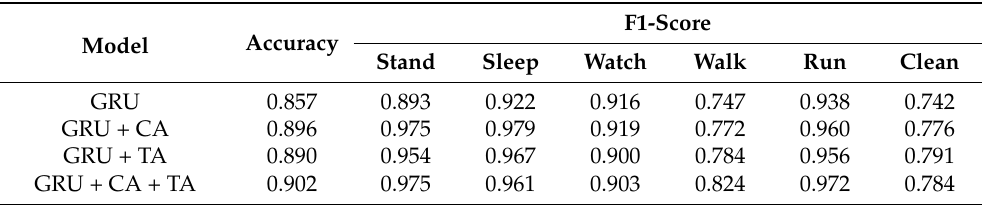
Table 4. Ablation experiments of the four attention models on the datasets without I.I.D. Model